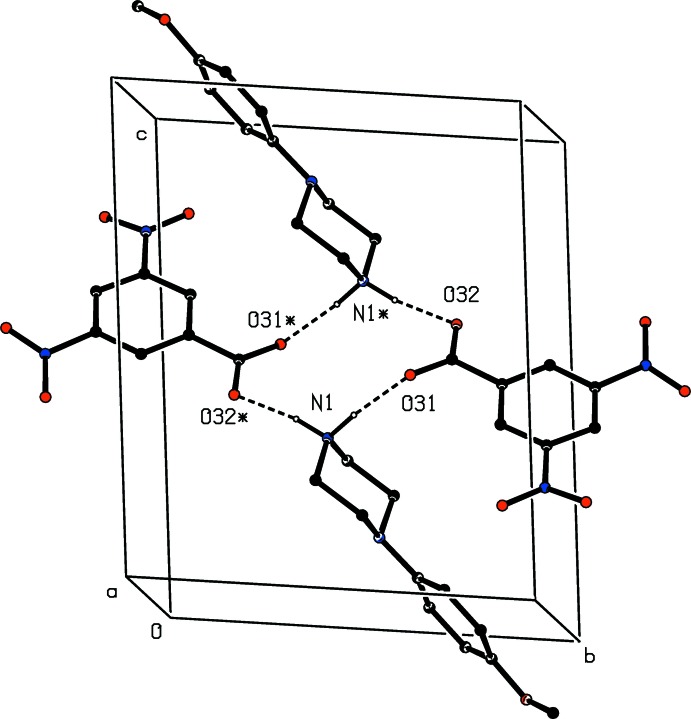
Part of the crystal structure of compound (II) showing the formation of a cyclic hydrogen-bonded (12) aggregate. Hydrogen bonds are drawn as dashed lines and, for the sake of clarity, the H atoms bonded to C atoms have been omitted. The atoms marked with an asterisk (*) are at the symmetry position (1 − x, 1 − y, 1 − z).